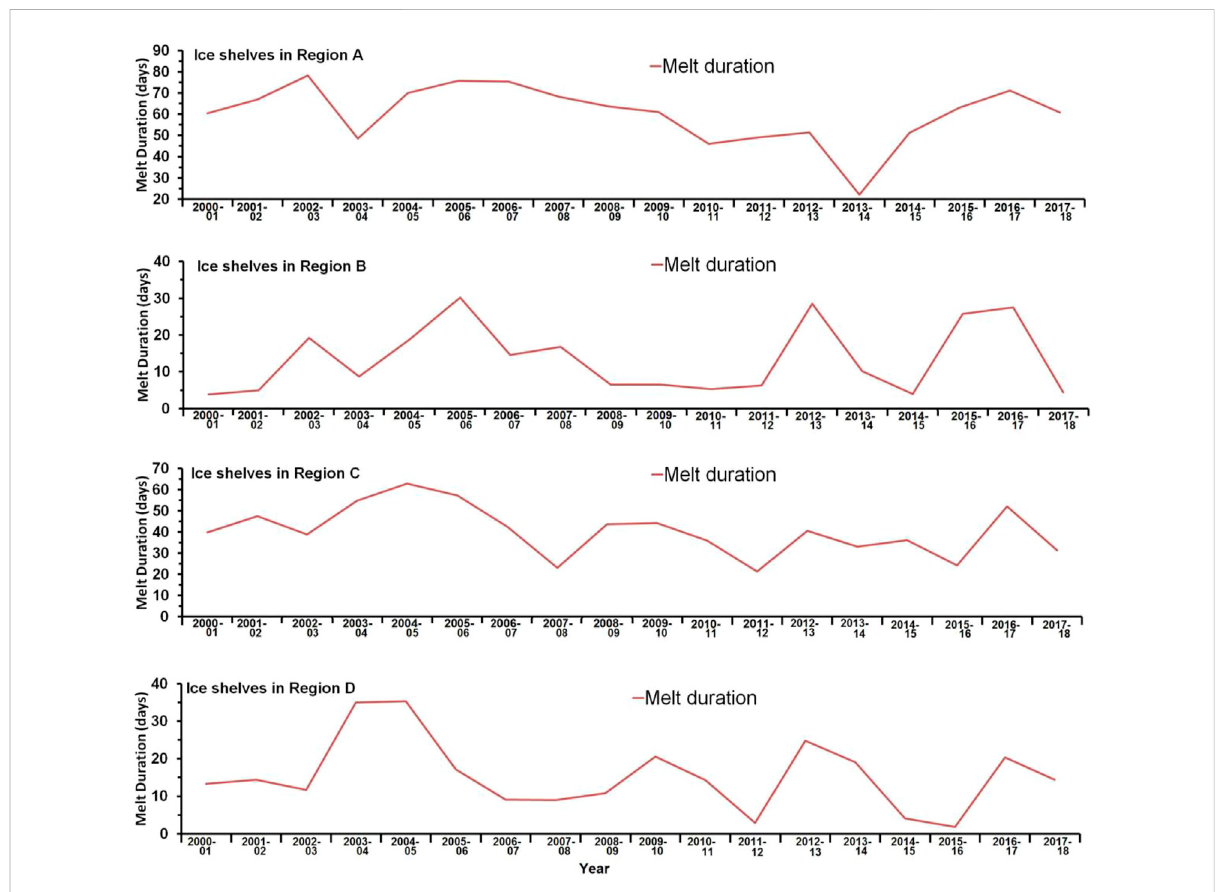
FIGURE 8 Time series of spatial-averaged melt duration at different regions demarcated in Figure